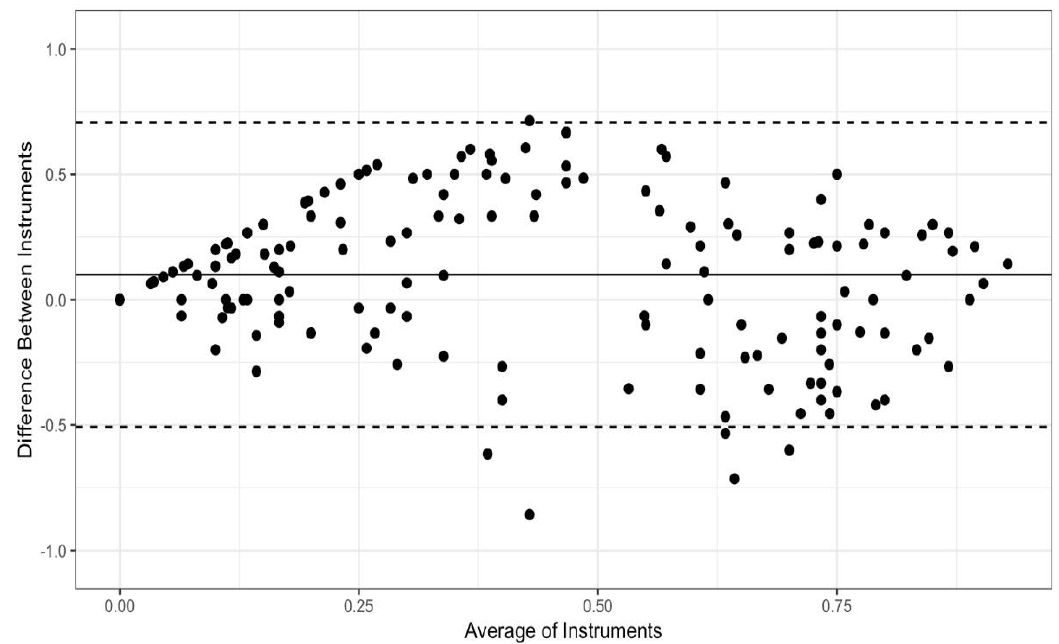
Figure 1. Bland-Altman plot for the PCL and the PTCL. Solid horizontal line represents the mean difference between instruments (the PCL minus the PTCL); dashed lines represent the 95% CI of differences.